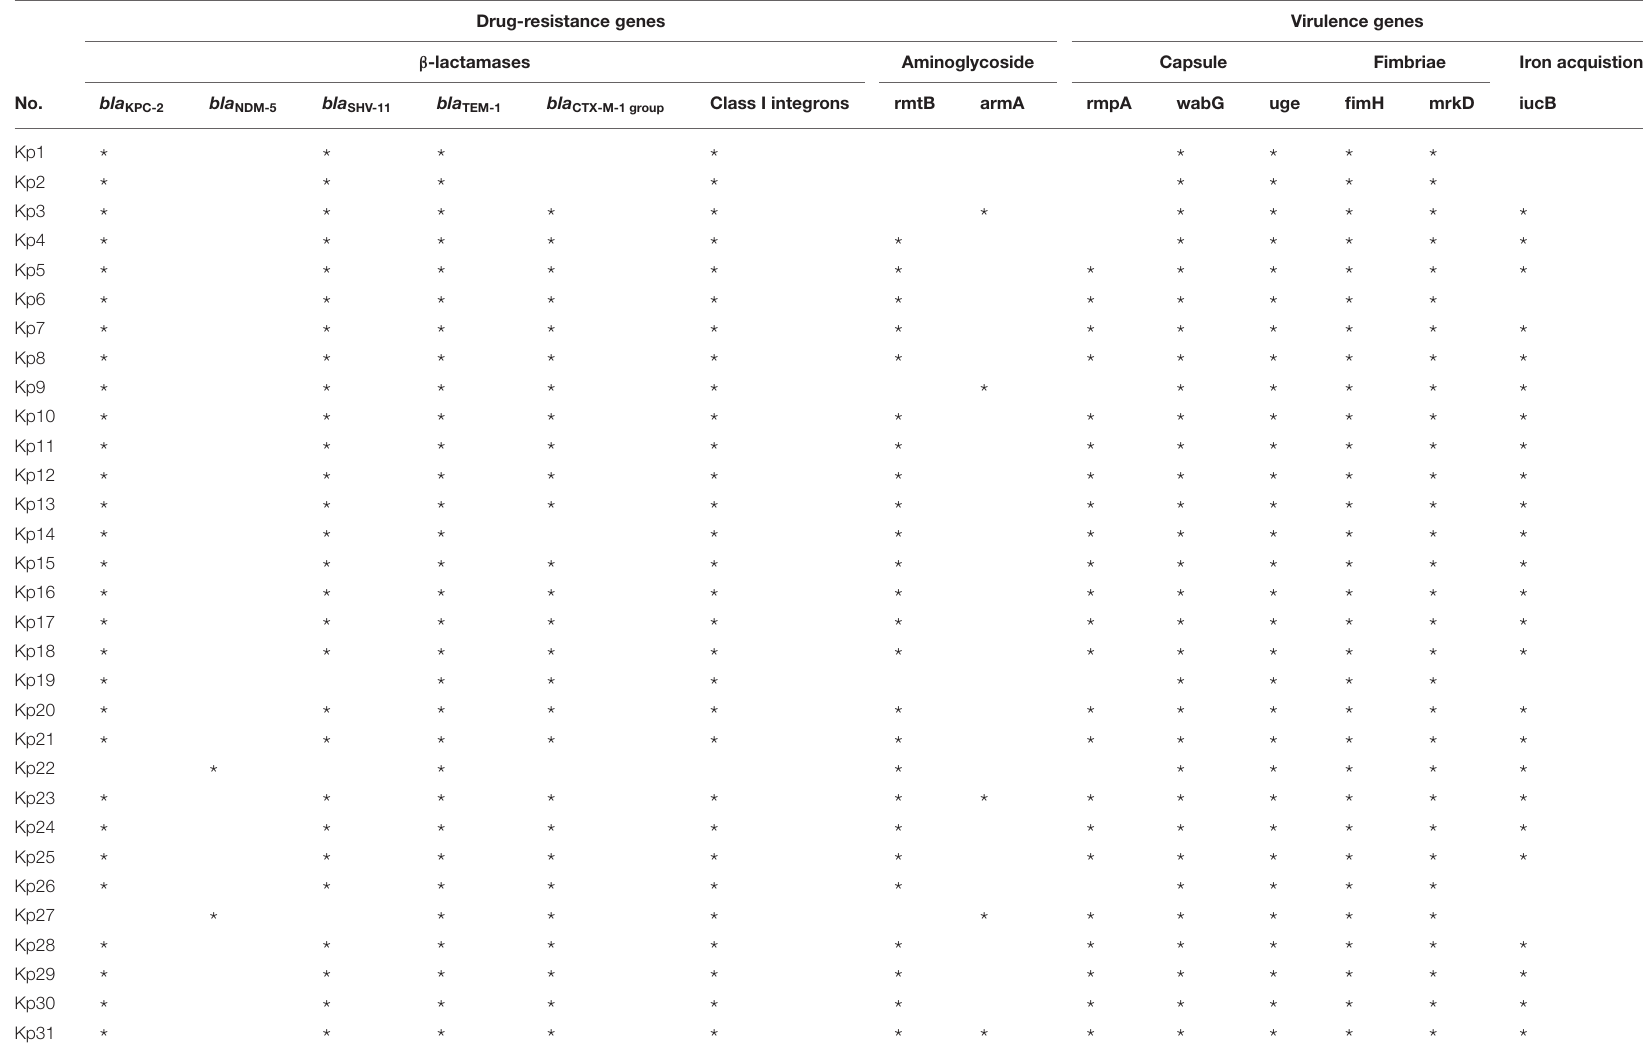
TABLE 3 | The drug-resistance genes and virulence genes of 31 CRKp